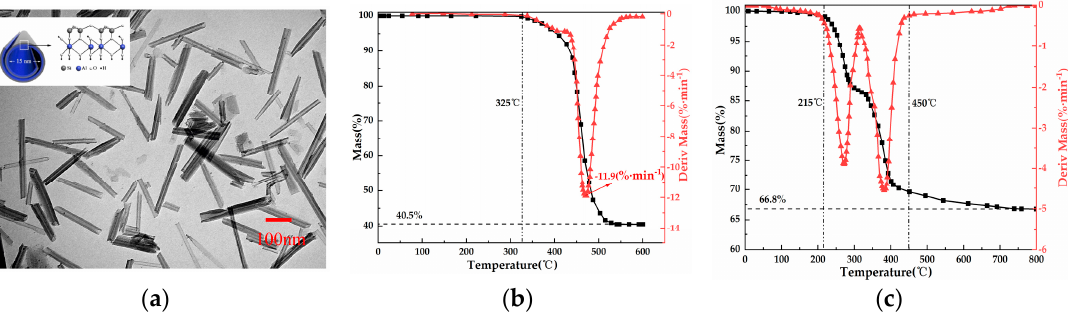
Figure 1. Properties of flame retardants: ( a ) SEM image of HNTs; ( b ) TGA-DTG curves of ADP; and ( c ) TGA–DTG curves of ATH.